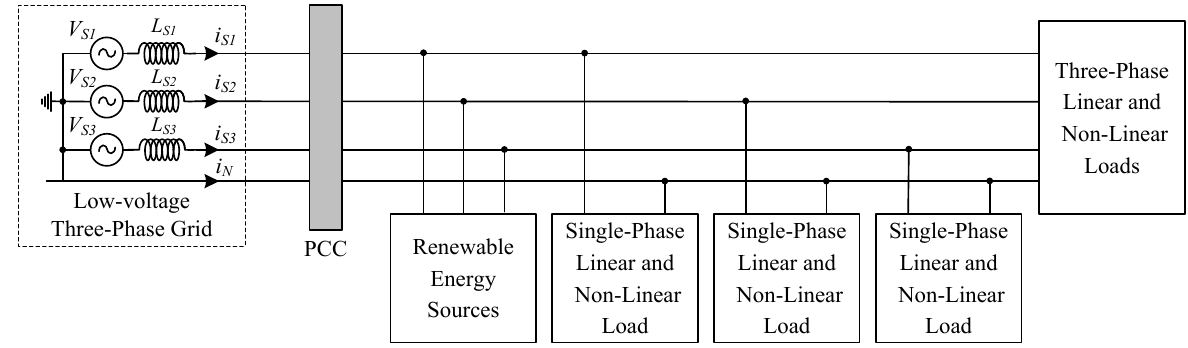
Figure 1. LV network characterized by a three-phase, four-wire connection in which the scattered distribution of the consumer loads can result in an asymmetric distribution.